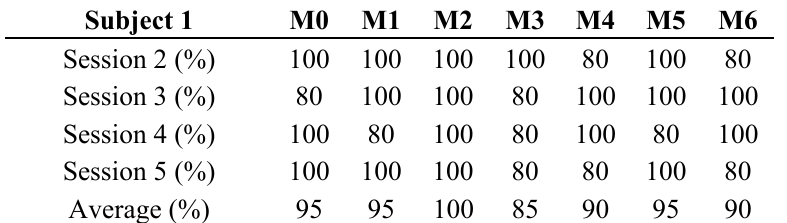
Table 3. Summary of the system average accuracy rate to the Subject 1.